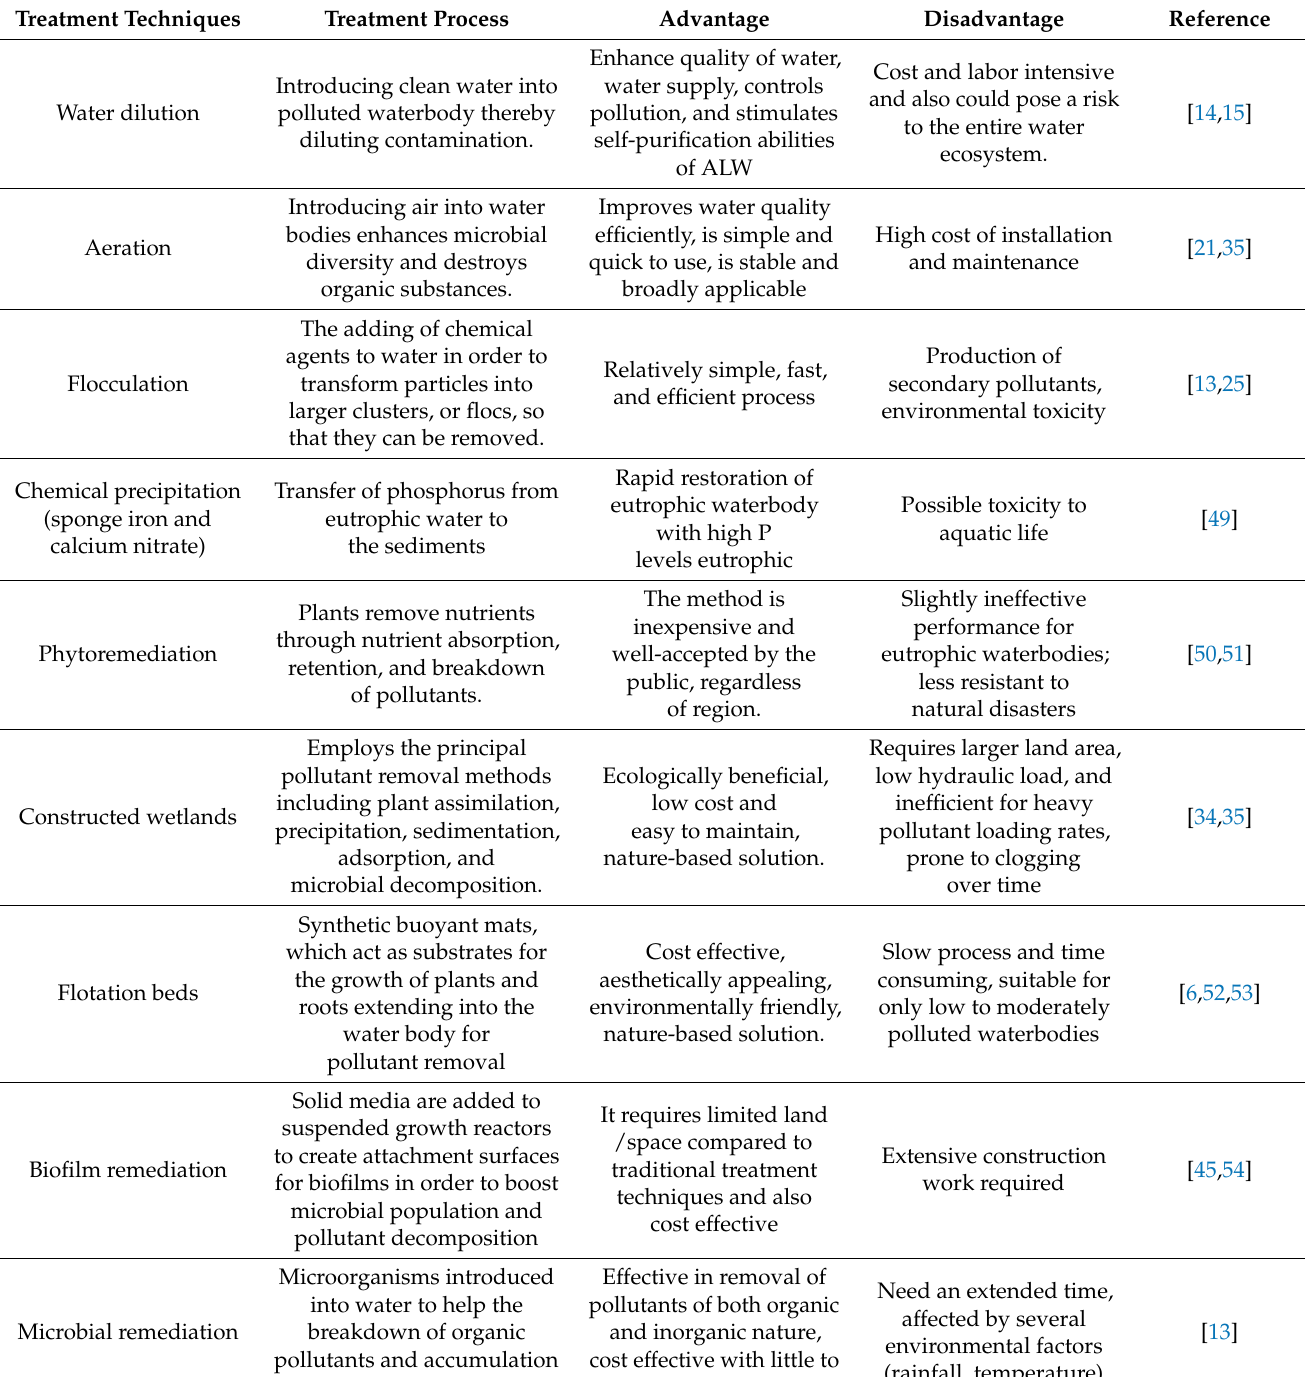
Table 1. Comparison of advantages and drawbacks of each type in